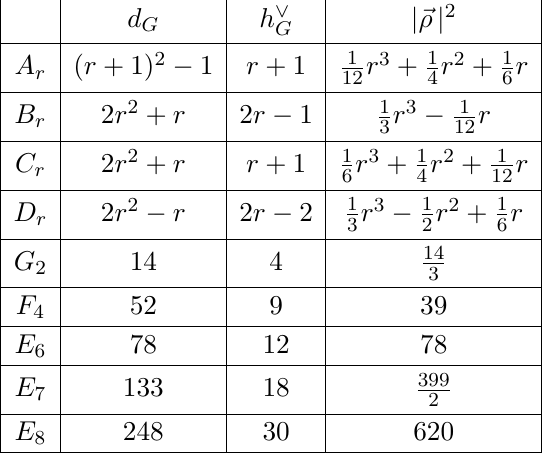
Table 7 . Dimension, dual Coxeter number, square of Weyl vector of Lie